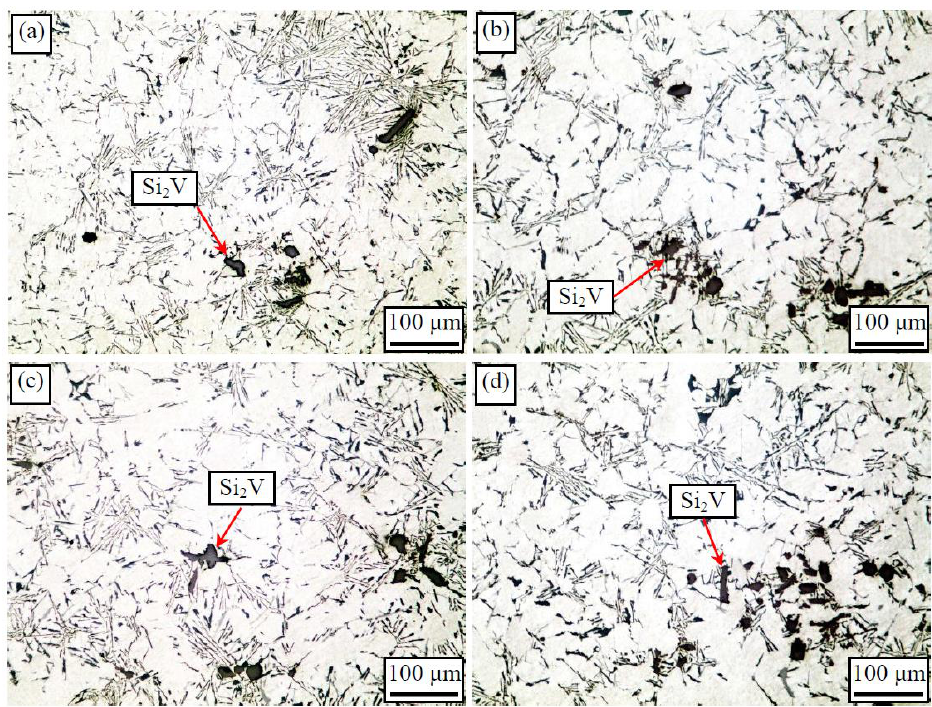
Figure 9. Optical micrographs of as-cast gravity casting A3 alloys treated by different physical fields: ( a ) no treatment; ( b ) UV; ( c ) ES; ( d ) UV-ES.